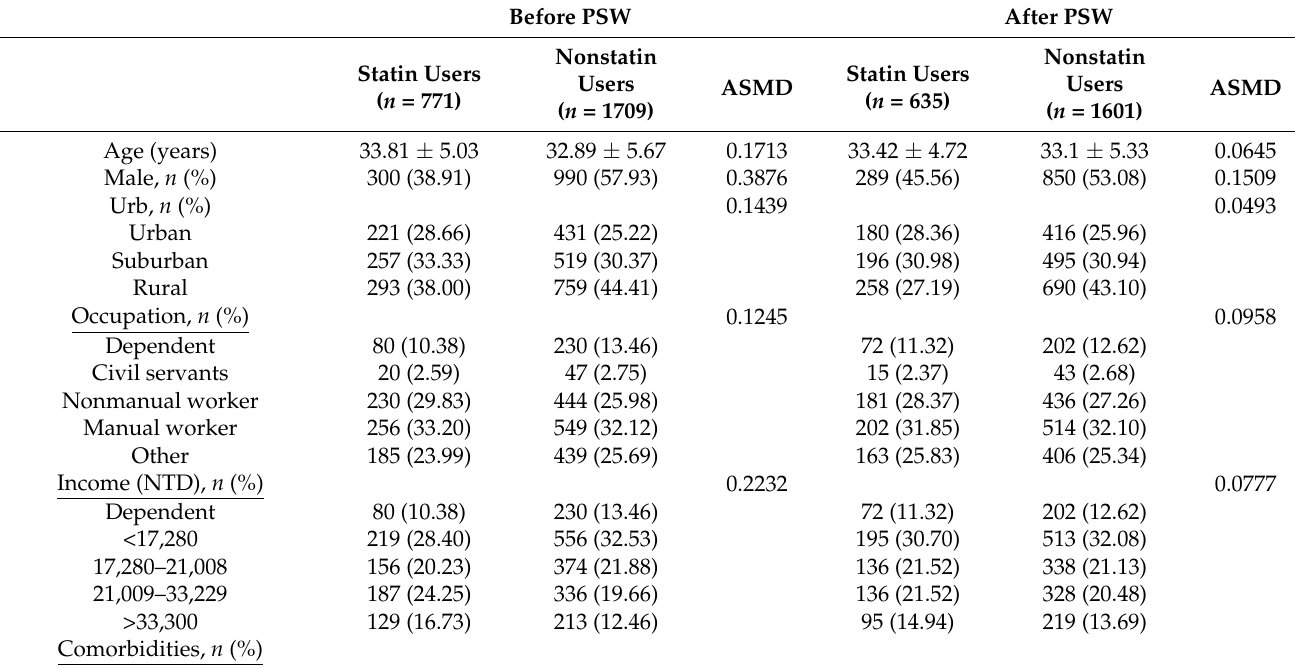
Table 1. Baseline characteristics of the study population before and after PSW matching. Before